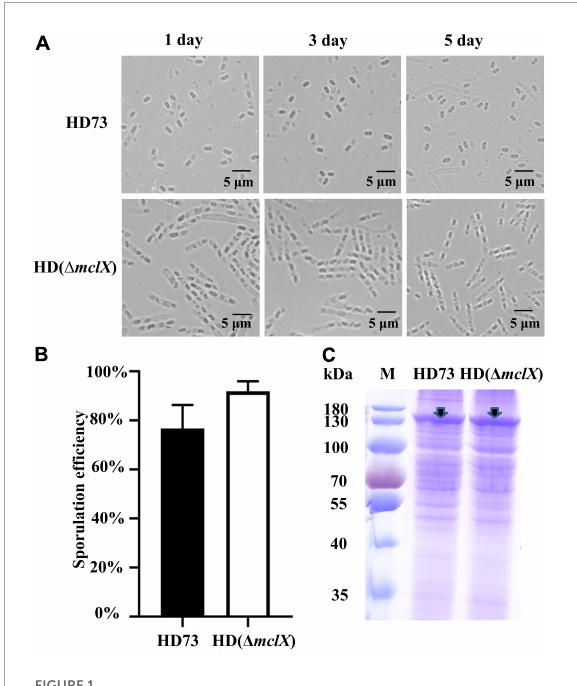
FIGURE1 Phenotype analysis of the HD ( (cid:49) mclX ) strain. (A) Phenotype of the wild-type strain HD73 and HD ( (cid:49) mclX ) at 1, 3, and 5 days after the bacterial growth reached the end of the exponential phase. Scale bars, 5 µ m; (B) sporulation frequency of the wild-type strain HD73 and HD ( (cid:49) mclX ). Error bars show the standard error of the mean; (C) Cry1Ac protein production in the wild-type strain HD73 and HD ( (cid:49) mclX ). Cry1Ac production bands are marked by arrows. Lane M, protein marker